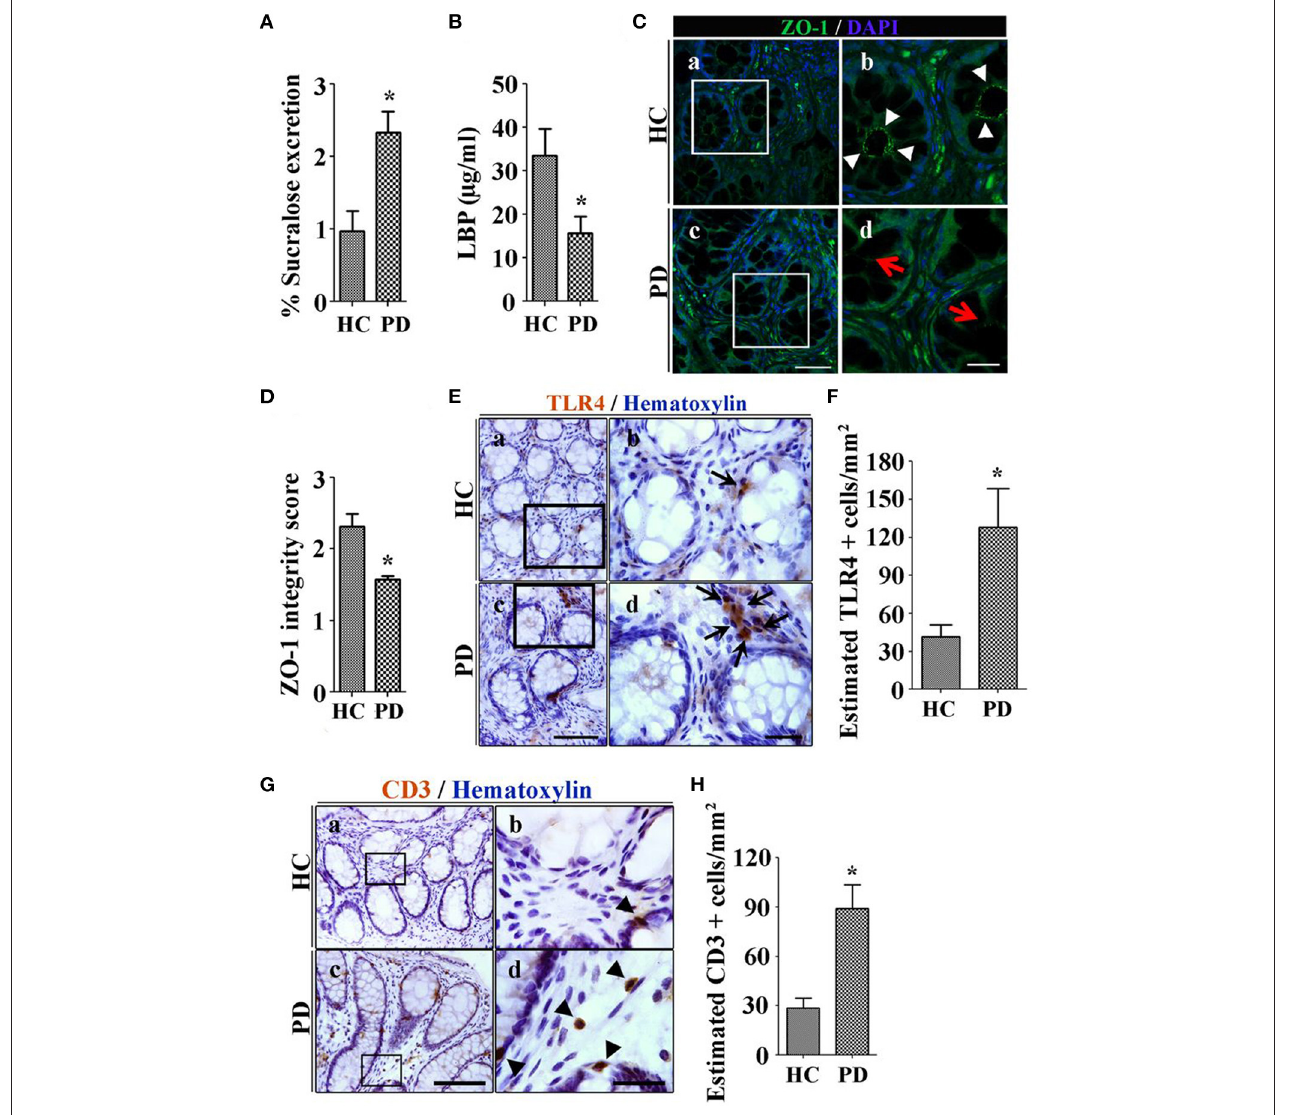
FIGURE 1 | Patients with Parkinson’s disease (PD) show increased colonic permeability and associated colonic inflammatory as well as immune markers in their biopsies compared with healthy controls (HC). (A) Per cent excretion of sucralose in the urine samples as an intestinal permeability marker. (B) Levels of LPS-binding protein (LBP) as a marker for systemic endotoxin in plasma samples. (C) Photomicrographs of immunofluorescence staining of tight junction protein zonula occludens 1 (ZO-1) in HC (a,b) and PD (c,d) colonic mucosa. (D) Integrity scoring for ZO-1 tight junction protein expression in colonic samples. (E) Photomicrographs of stained toll-like receptor 4 (TLR4) + cells in lamina propria of the HC (a,b) and PD mucosa (c,d). (F) Estimated TLR4 + cells expressed as number/mm 2 . (G) Photomicrographs of stained CD3 + T cells in colonic mucosa of HC (a,b) and PD (c,d). (H) Assessment of CD3 + cells in lamina propria of colonic samples. Scale bars: C(c) = 50 µ